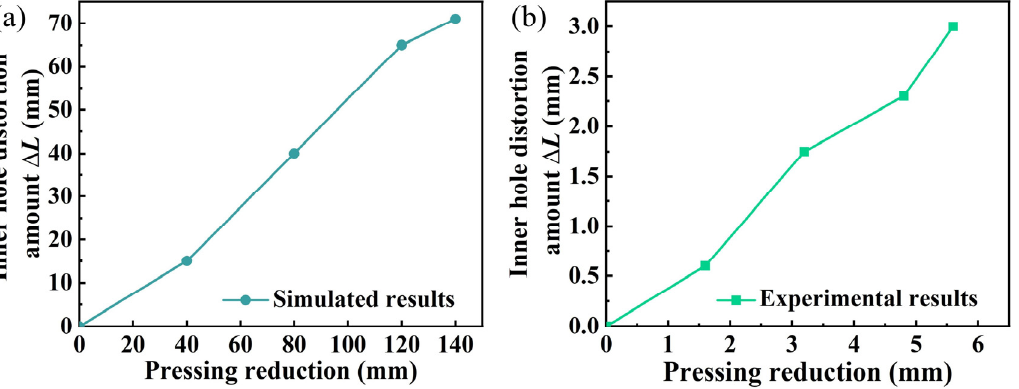
Figure 10. Distortion trend of the inner hole with different pressing reductions: ( a ) simulated results; ( b ) experimental results with a shrinkage ratio of 25:1.